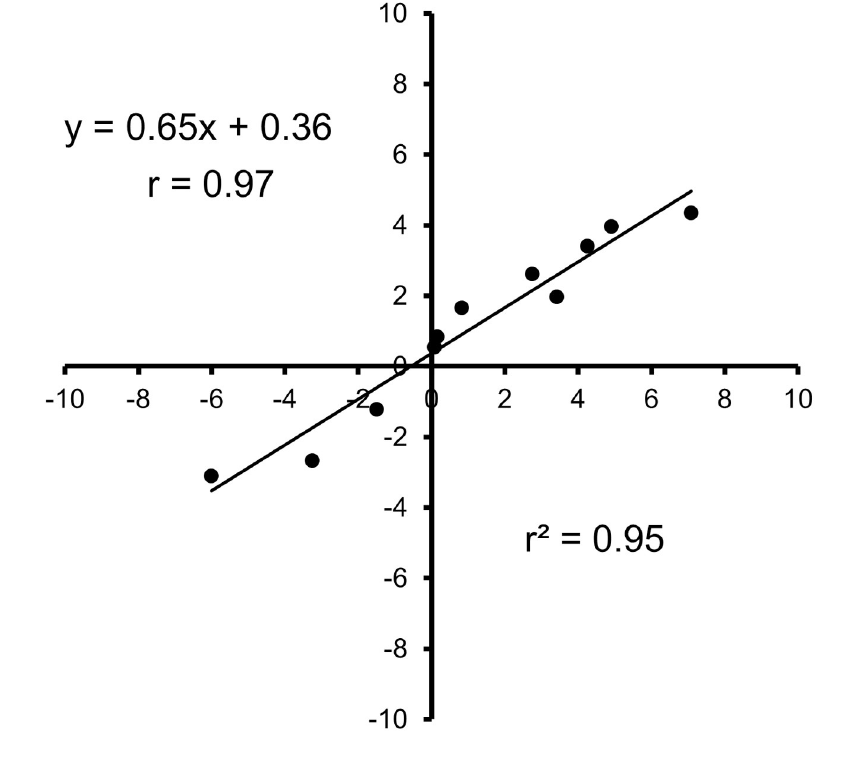
Fig 4. Scatterplots between mean predicted (objective) and perceived (subjective) hedonic ratings in response to 11 stimuli in 12 participants (group analysis). The mean calculated hedonic ratings are shown in the ordinates and the perceived hedonic ratings in the abscissas. The Pearson’s correlation coefficient between the two ratings was very highly significant ( P < 0.001).